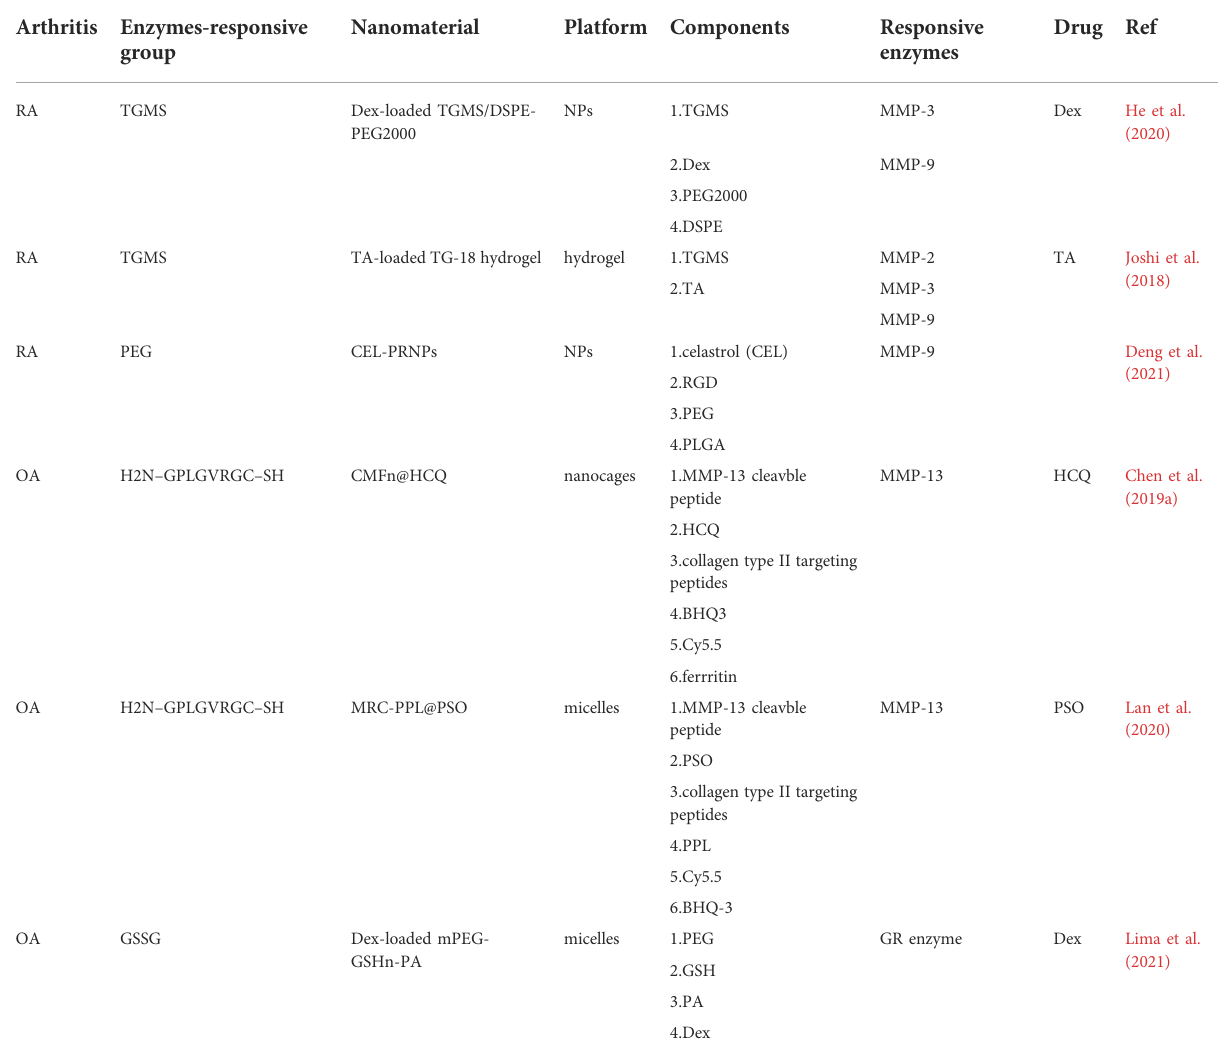
TABLE 1 The biomaterials that target the upregulated enzymes in arthritis. Arthritis Enzymes-responsive